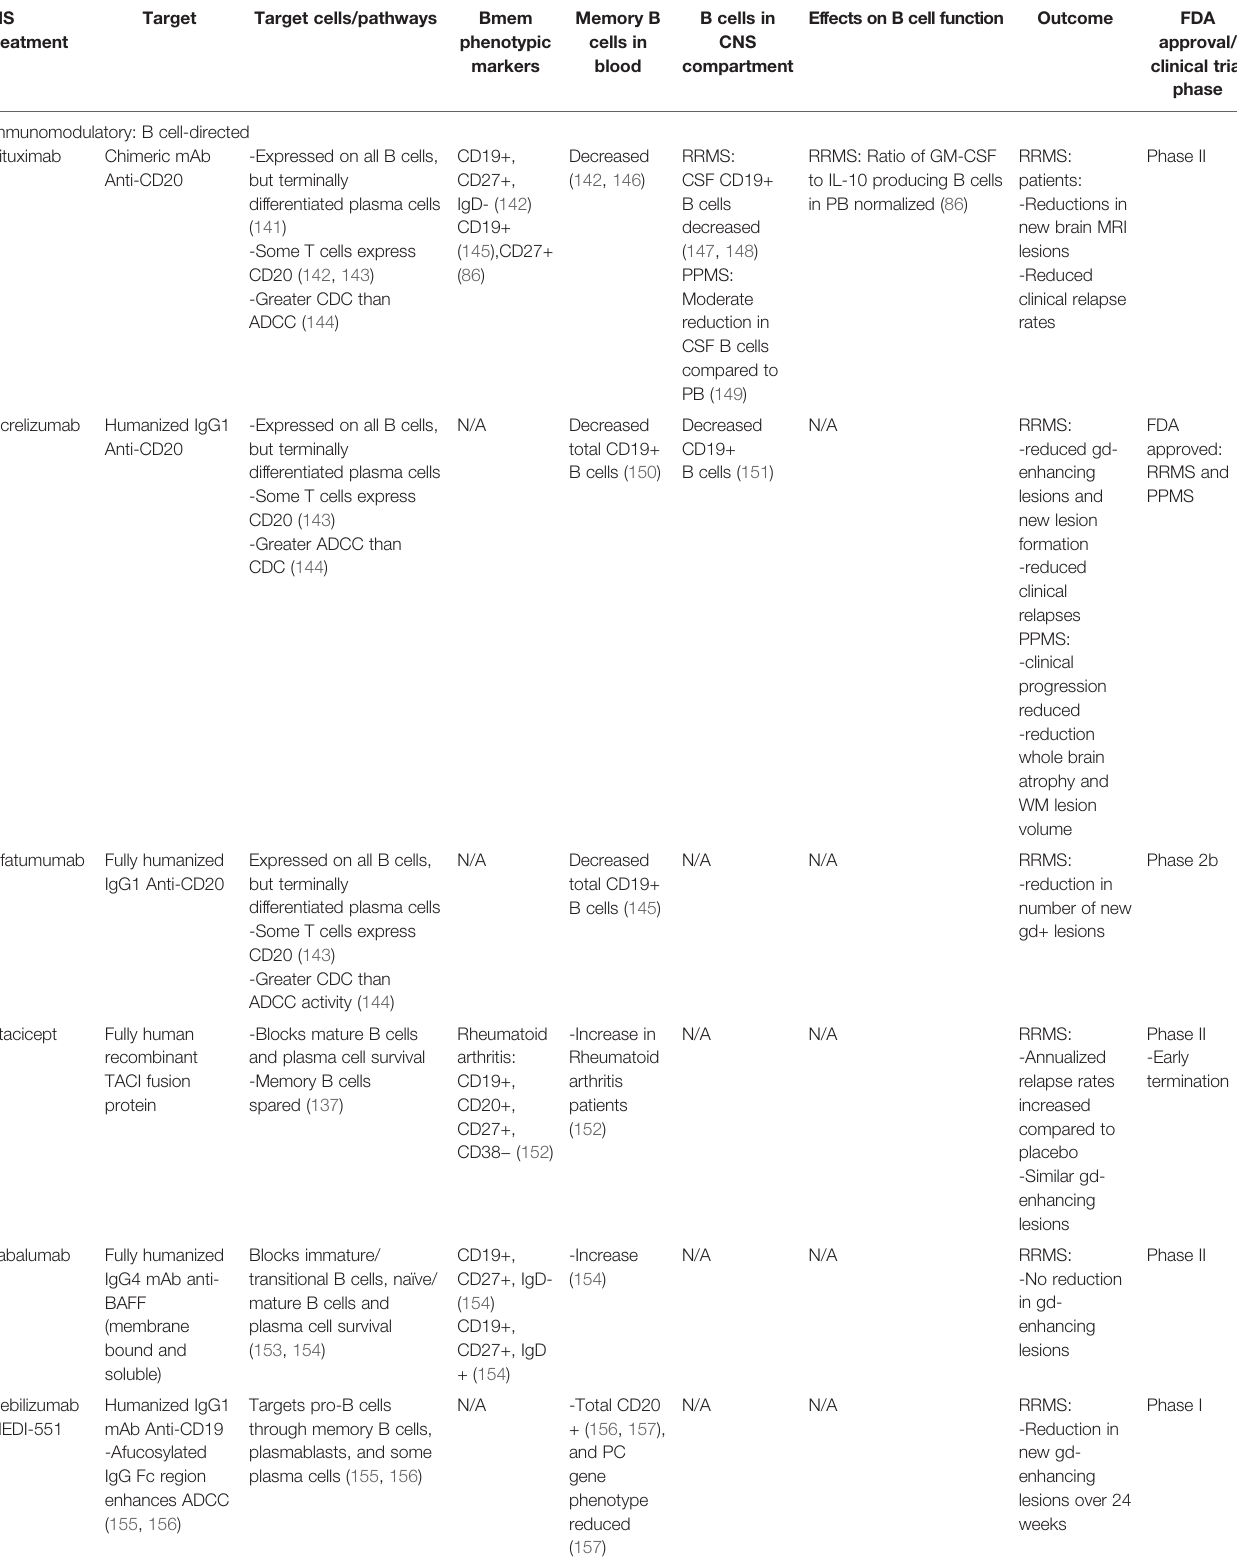
TABLE 1 | Immunomodulatory MS treatment effects on Bmem and B cell